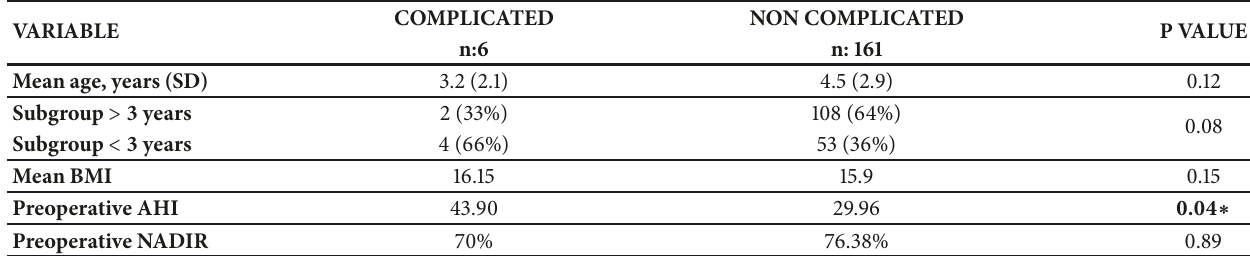
Table 2: Patient’s characterization according to risk groups.